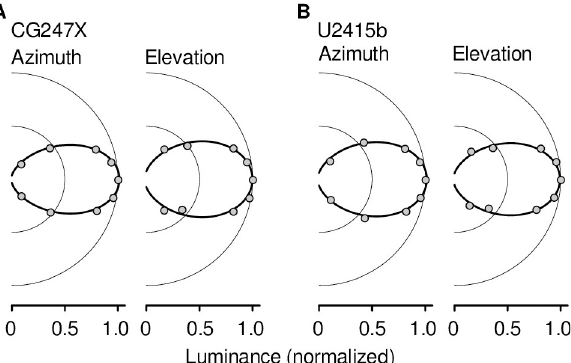
Fig 3. Polar plots, showing effective luminance as a function of viewing angle. We presented a large, static test patch, measuring luminance with the LS-110 spot meter near the display’s center. We used a turntable to rotate the display ( Methods ), measuring the effective luminance as a function of azimuth and elevation. Each symbol shows the average of six measurements, normalized to peak. Error bars, showing the full range of measurements, were in all cases obscured by plot symbols. Solid curves show fitted circular von Mises functions ( Methods ) used to estimate full-width at 90%-maximum.